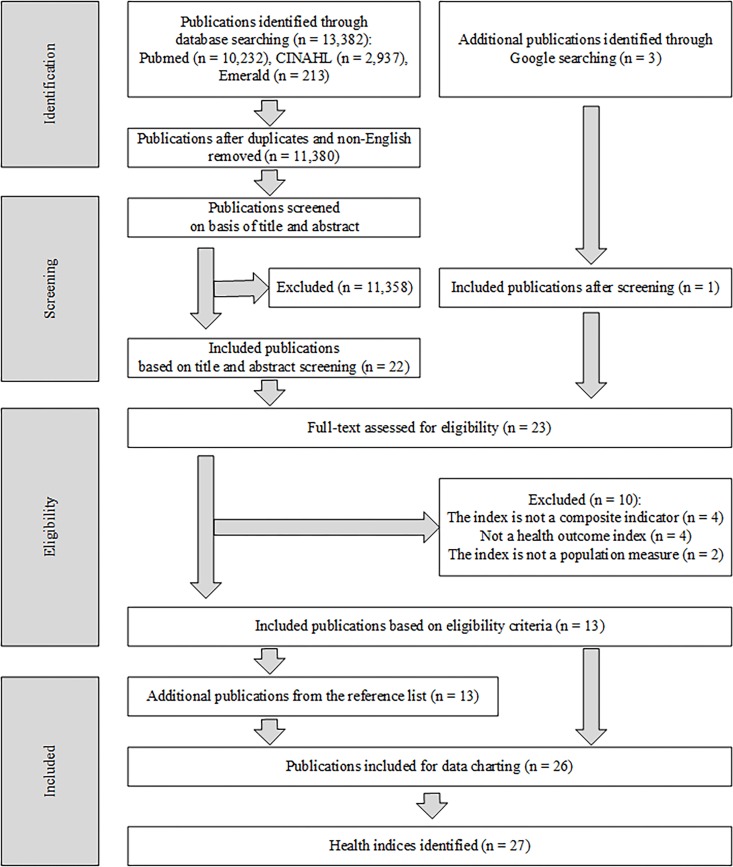
PRISMA flow diagram.